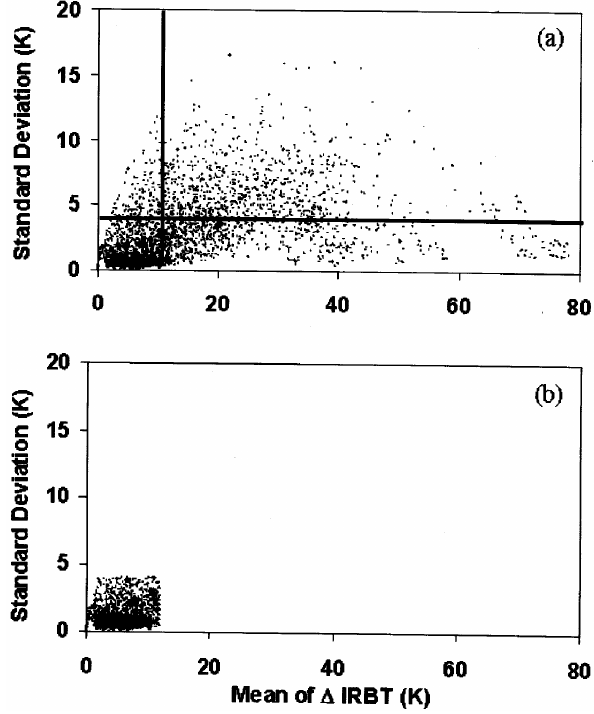
Fig. 3. Arch diagrams for a 3 × 3 pixel array of a 60 × 60 pixel box from a Difference Image (DI) and their classification according to the cloud algorithm. A typical arch with its clear foot delimited (top panel) and the foot classified as fully clear (bottom panel).